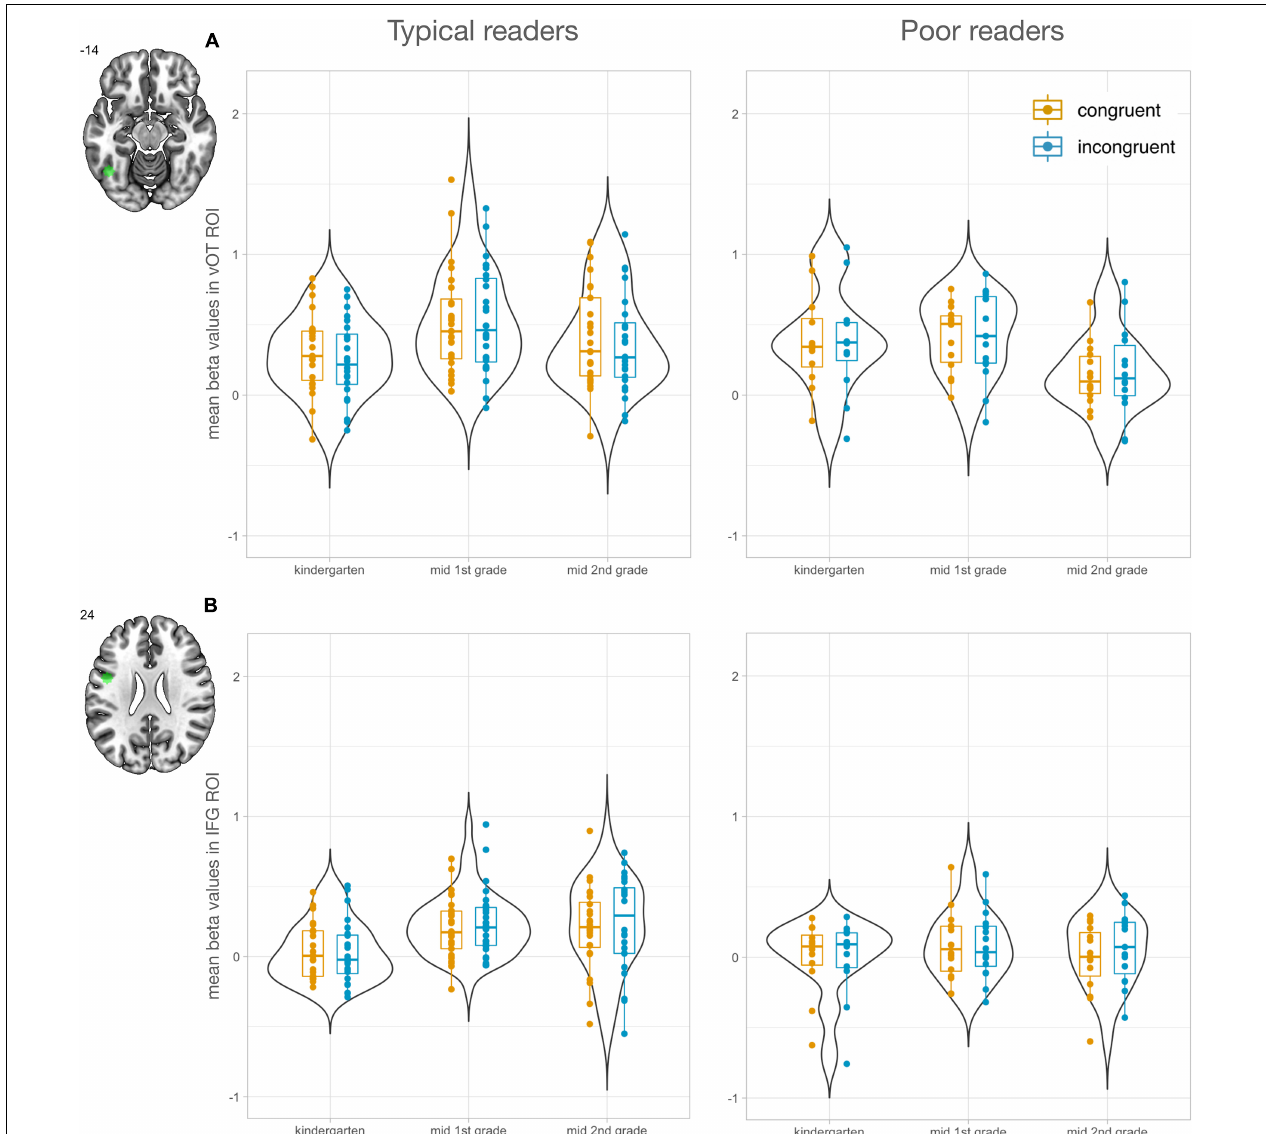
FIGURE 2 | Letter-specific region of interest analyses ( n = 47). Left panels show values for typical readers and right panels for poor readers. Mean responses to congruent letter-speech sound pairs are shown in orange and to incongruent in blue. (A) Mean beta values in left vOTC ROI increased from kindergarten (T1) to 1st grade (T2) and second grade (T3) in the typical reading group, while the poor reading group showed a significant decrease from 1st grade (T2) to second grade (T3). (B) Mean beta values in left IFG ROI increased from kindergarten (T1) to 1st grade (T2) and second grade (T3) in the typical reading group. IFG activation was significantly higher for typical readers than poor readers at